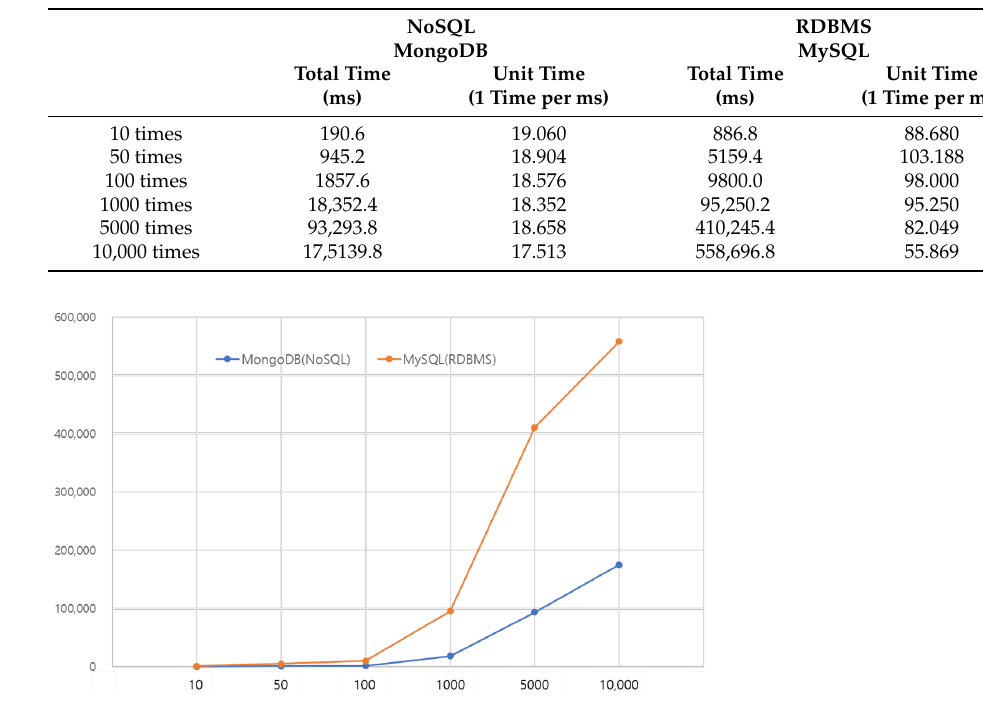
Table 3. Results of delete experiment.